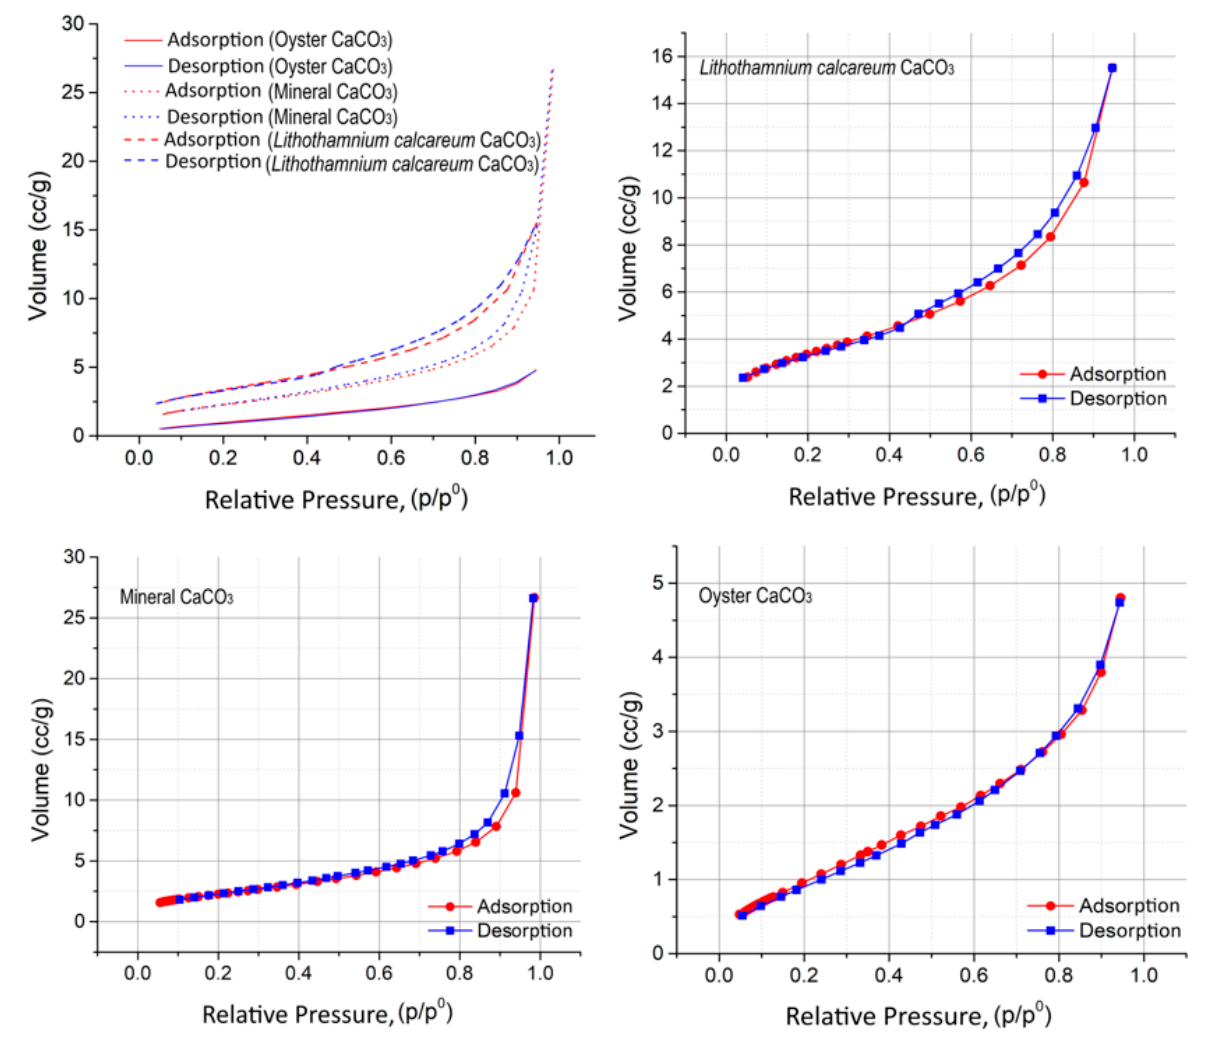
Figure 1. Profiles of adsorption and desorption of type III isotherms. The first graph represents the comparative profiles of the CaCO 3 samples according to the scales.